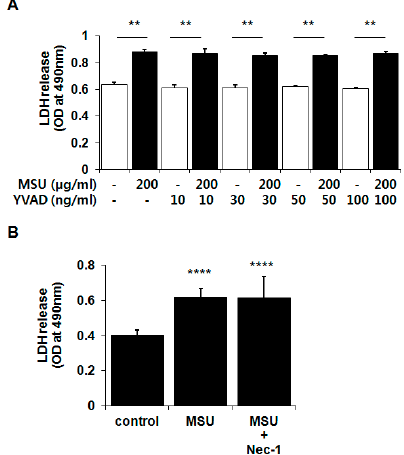
Figure 5. MSU crystal-induced chondrocyte death was independent of ( A ) pyroptosis and ( B ) Figure necroptosis. Chondrocytes were exposed to ( A ) Ac-YVAD-CHO (YVAD; 10, 30, 50, and 100 ng/mL) or ( B ) necrostatin-1 (Nec-1; 30 µM) 3 h prior to treatment with MSU crystals (200 µg/mL) for 24 h. Cell viability was measured by a LDH release assay. Data represent the mean ± SD for triplicate experiments from three different donors. ( A ) ** p < 0.01 vs. YVAD-only treated cells; ( B ) **** p < 0.001 vs. untreated cells. ( A ) White bar, without MSU crystals; black bar, with MSU crystals.